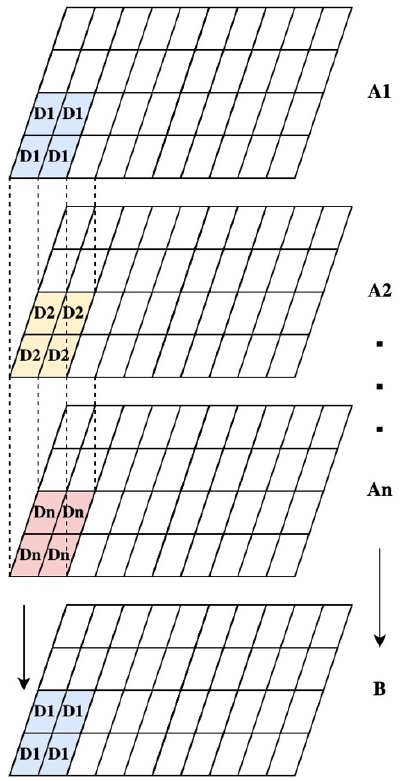
Figure 2. Explanation diagram for overlapping values.